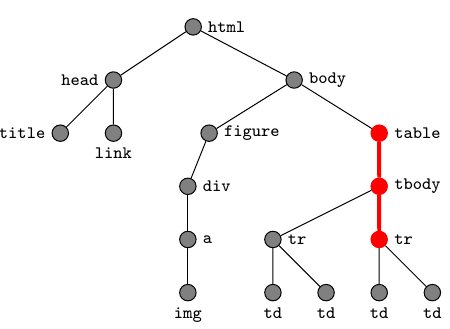
Figure 3. A subpath: tr:tbody:table